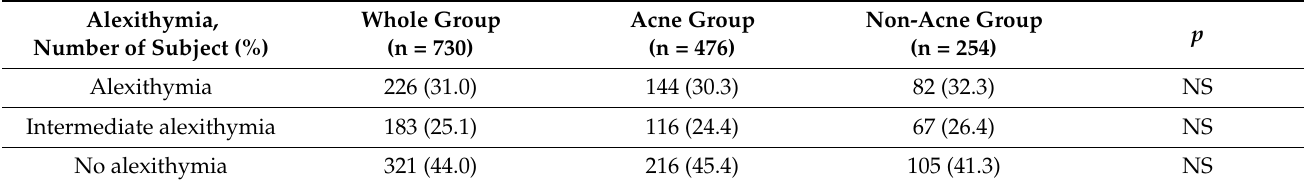
Table 1. Alexithymia in pupils with and without